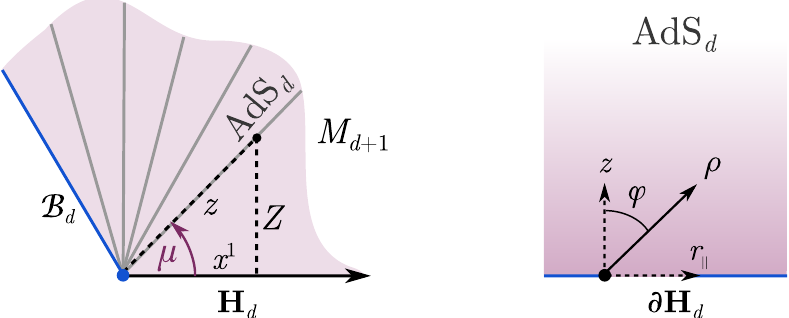
Figure 1. Left . Janus slicing for bulk dual M d +1 of a BCFT d . The warp factor is represented by a purple envelope. Right . Coordinates for AdS d , with time and (cid:10) d (cid:0) 3 directions